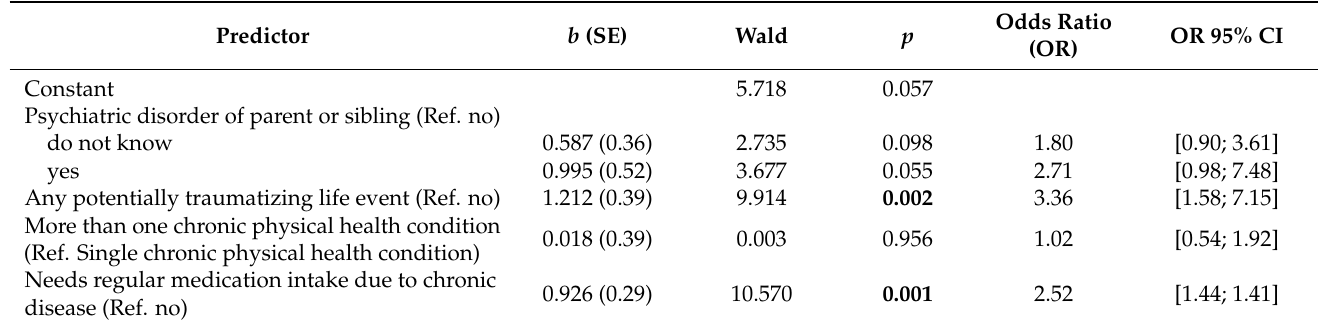
Table 3. Multivariate logistic regression model predicting clinically relevant mental health problems in adolescents with a chronic physical health condition.